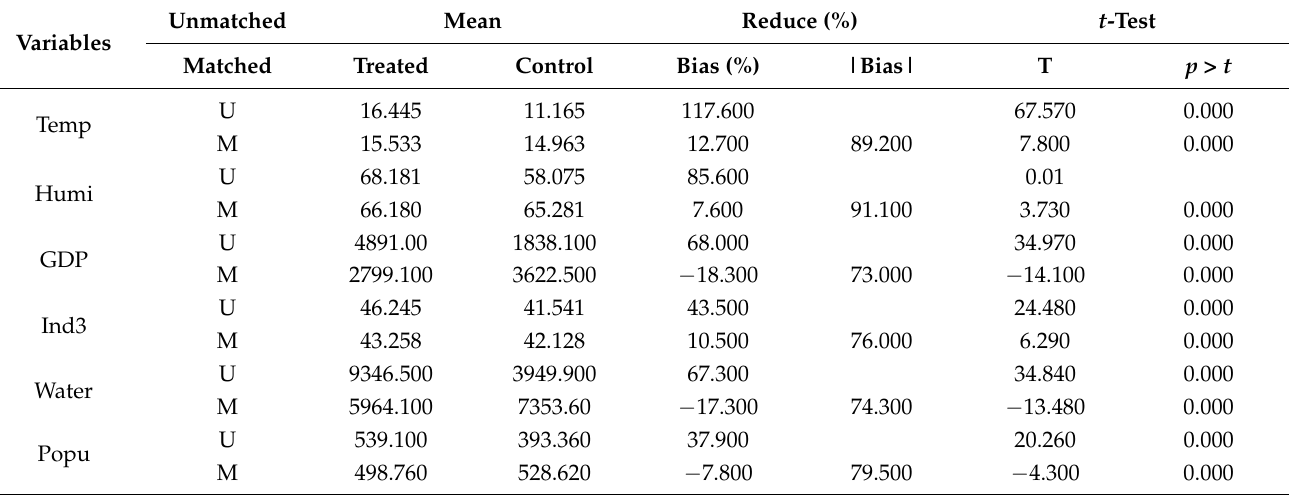
Table 3. PSM model